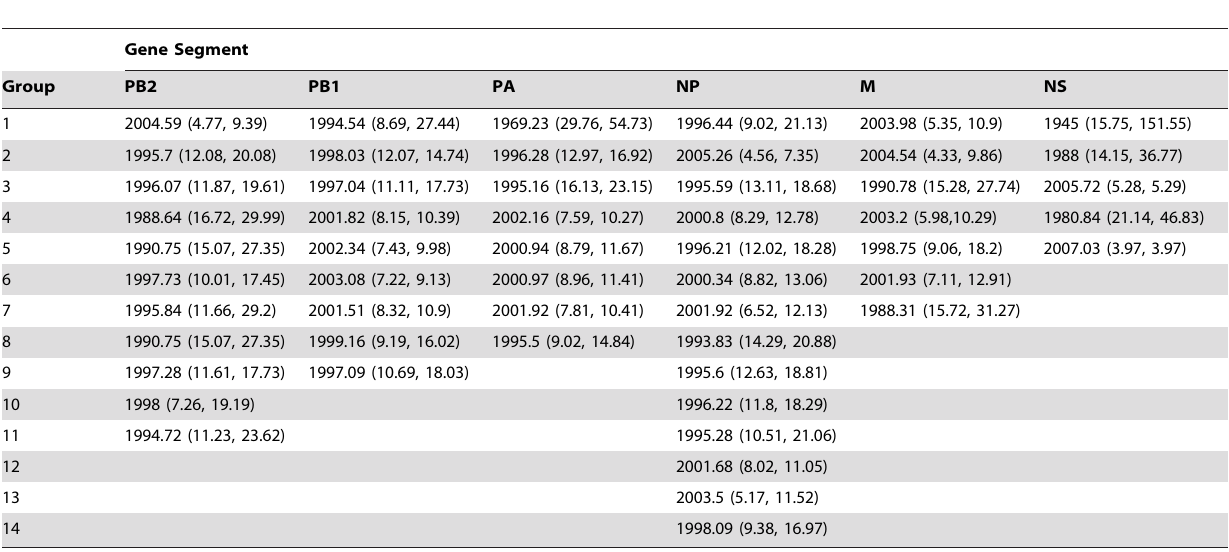
Table 3. Estimated calendar year (with decimals) of the most recent common ancestor (TMRCA) of phylogenetic groups 1 to 14 described in Figures 2 and